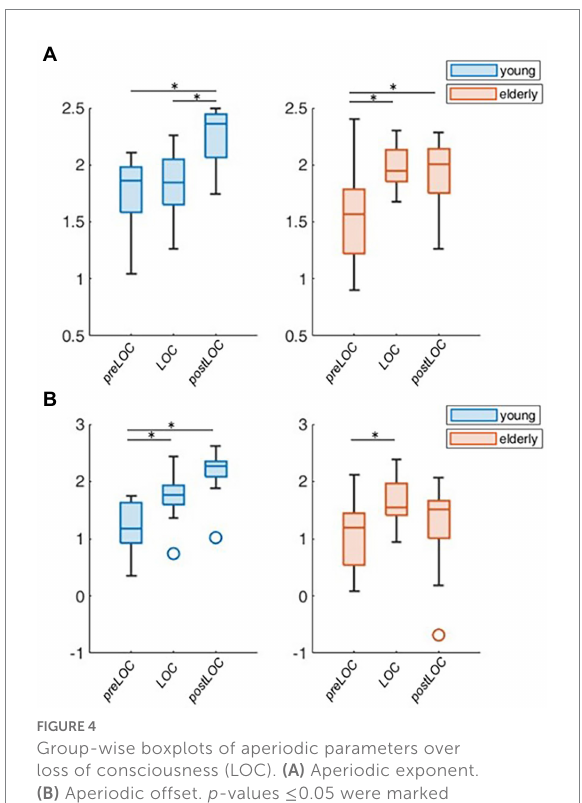
FIGURE 4 Group-wise boxplots of aperiodic parameters over loss of consciousness (LOC). (A) Aperiodic exponent. (B) Aperiodic offset. p -values ≤ 0.05 were marked with a *.